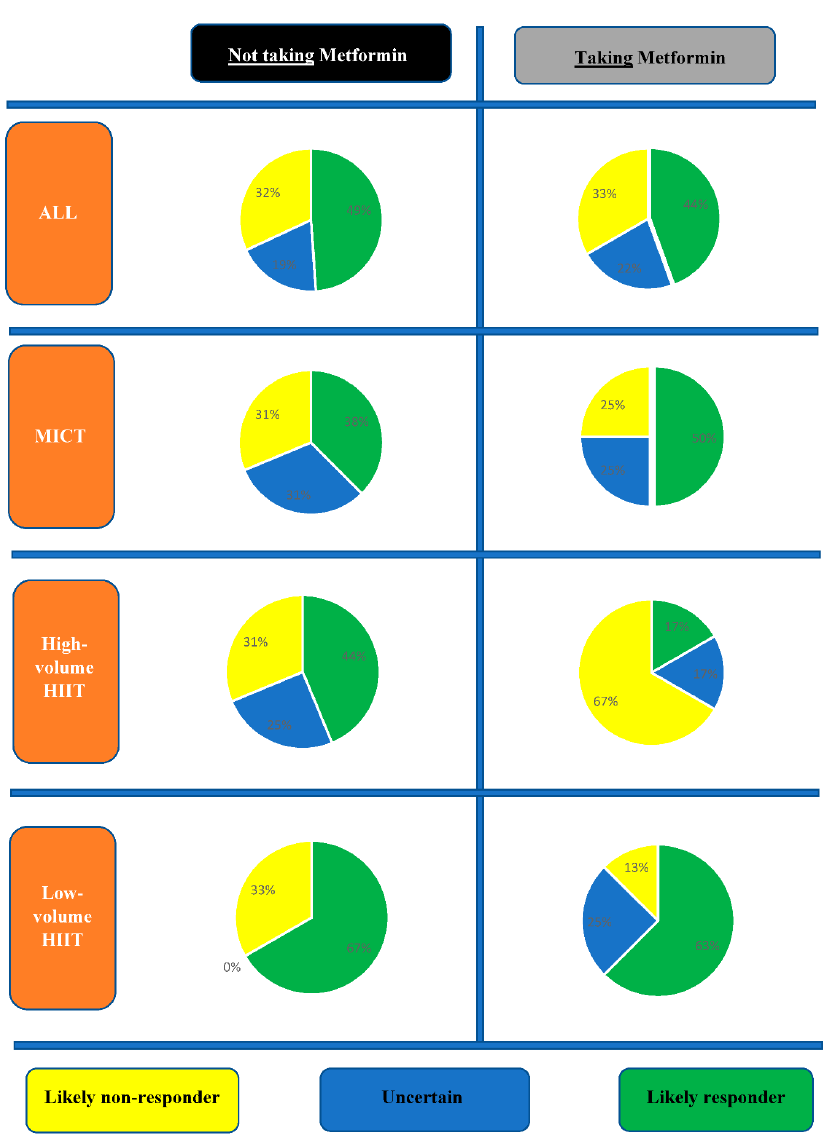
Figure 3. Proportions of response categories in metabolic syndrome (MetS) z-score change following exercise interventions in participants not taking or taking metformin.